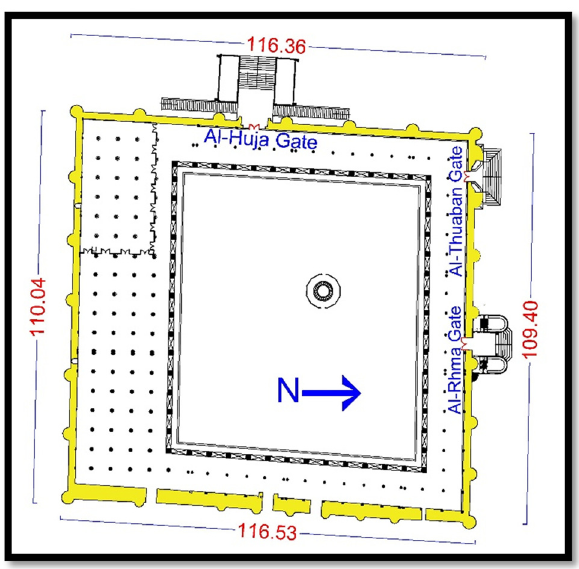
Figure 1: As - built drawing plan of Al - Kufa Mosque.